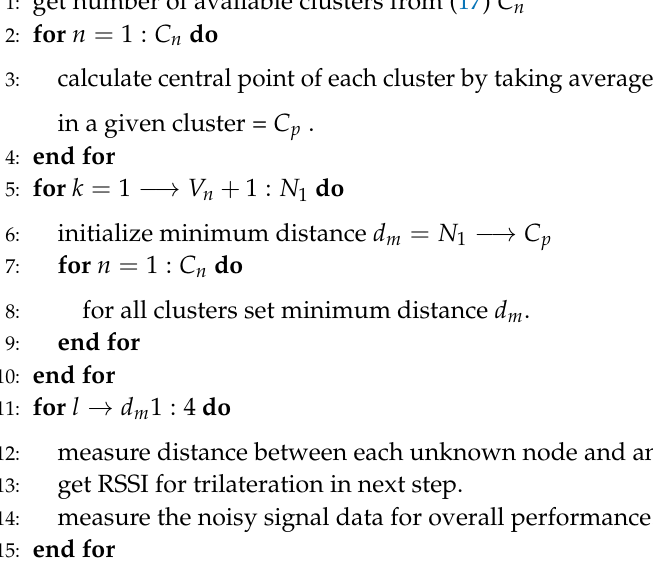
Algorithm 2 Clustering